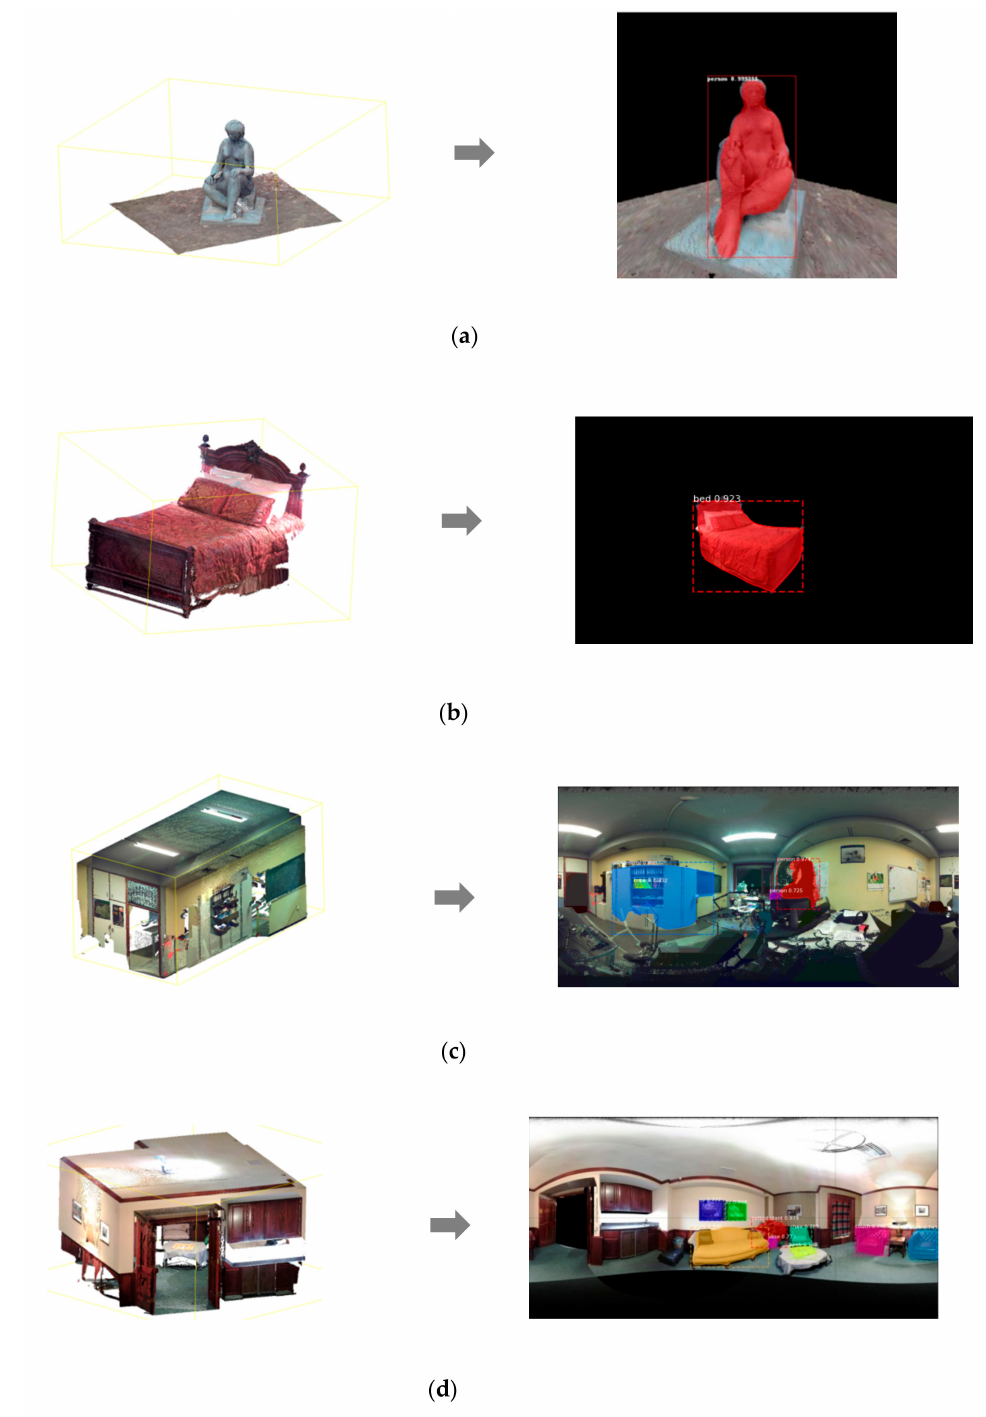
Figure 27. Instance segmentation on different point cloud panoramic images: ( a ) Office point cloud; ( b ) Female Statue point cloud; ( c ) Bed point cloud; ( d ) Boardroom point